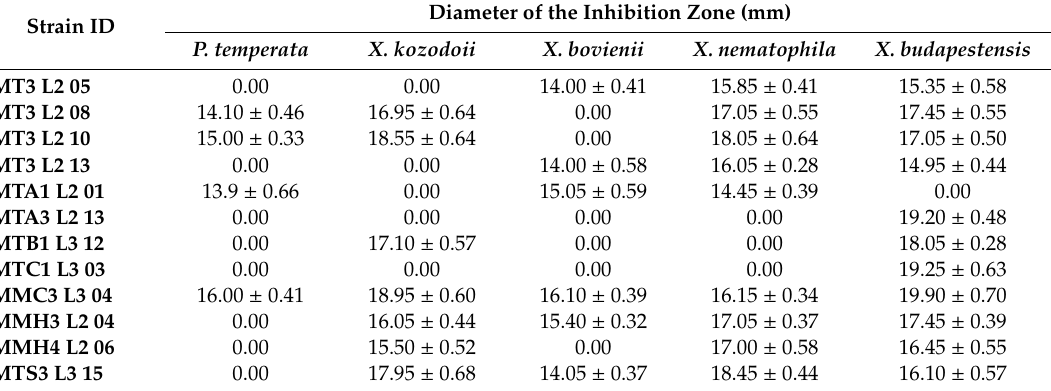
All data are expressed as mean ± SD, n = 10.